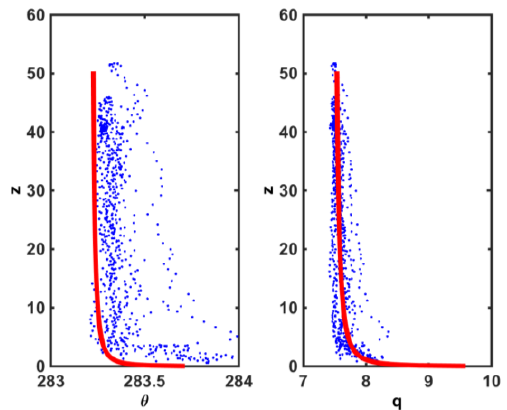
Figure 4. Mean surface layer profiles obtained from Dataset 1 using a cost function without the 1/z factor. The units for θ and 𝑞 are the same as in Figure 3.